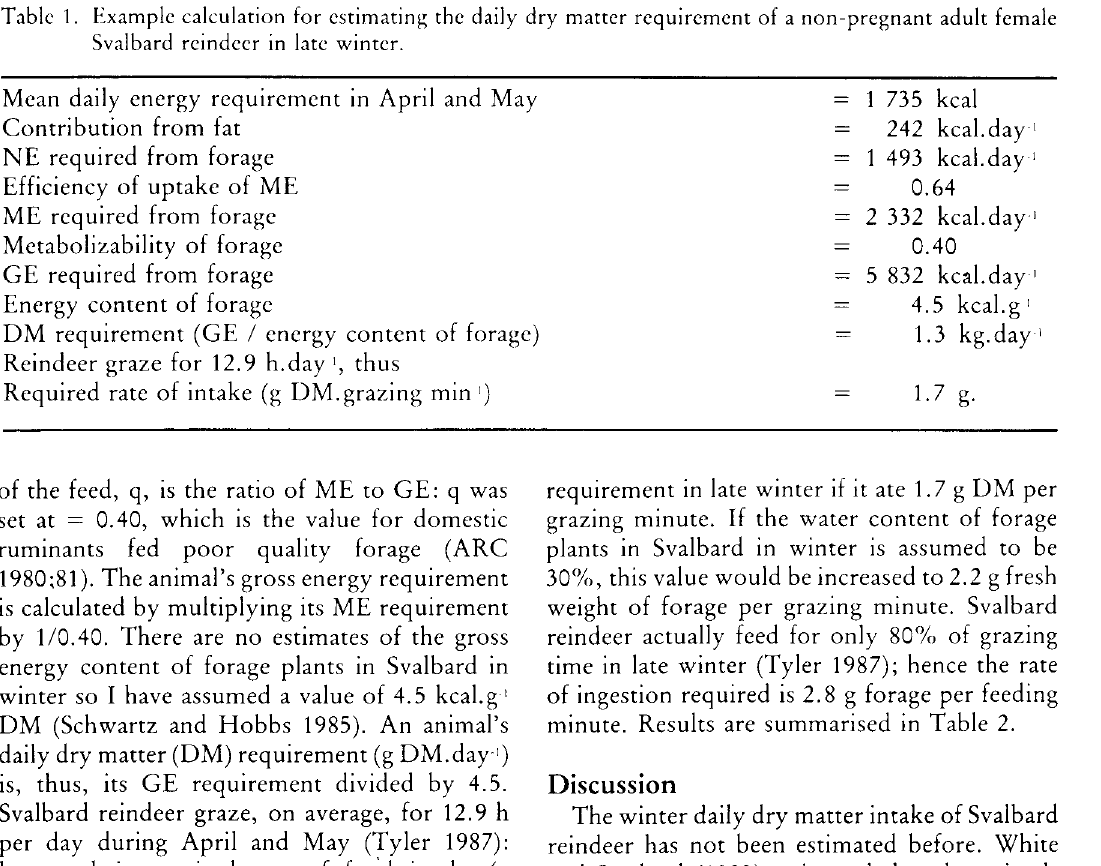
Table 2. Rates of ingestion necessary for pregnant and non-pregnant adult female Svalbard reindeer to meet their daily energy requirements late in